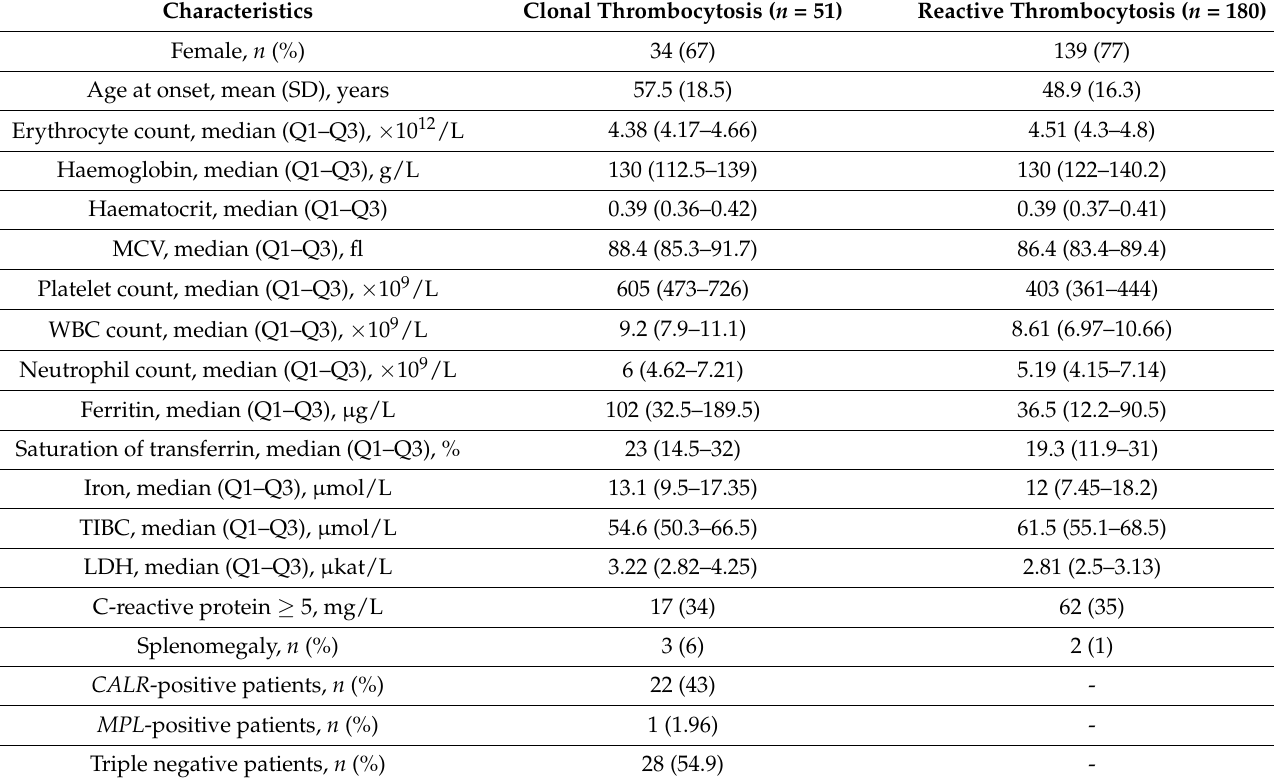
Table 1. Main characteristics of our patients ( n = 231).